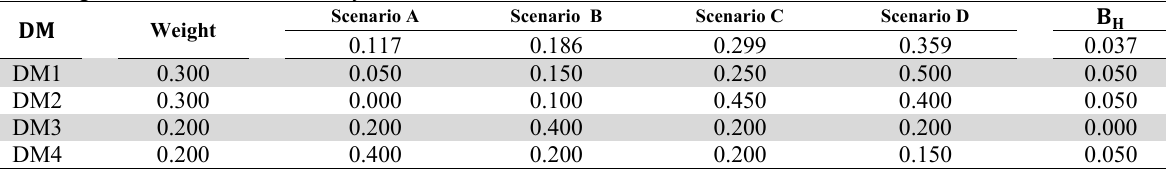
Belief degree based on evidence theory